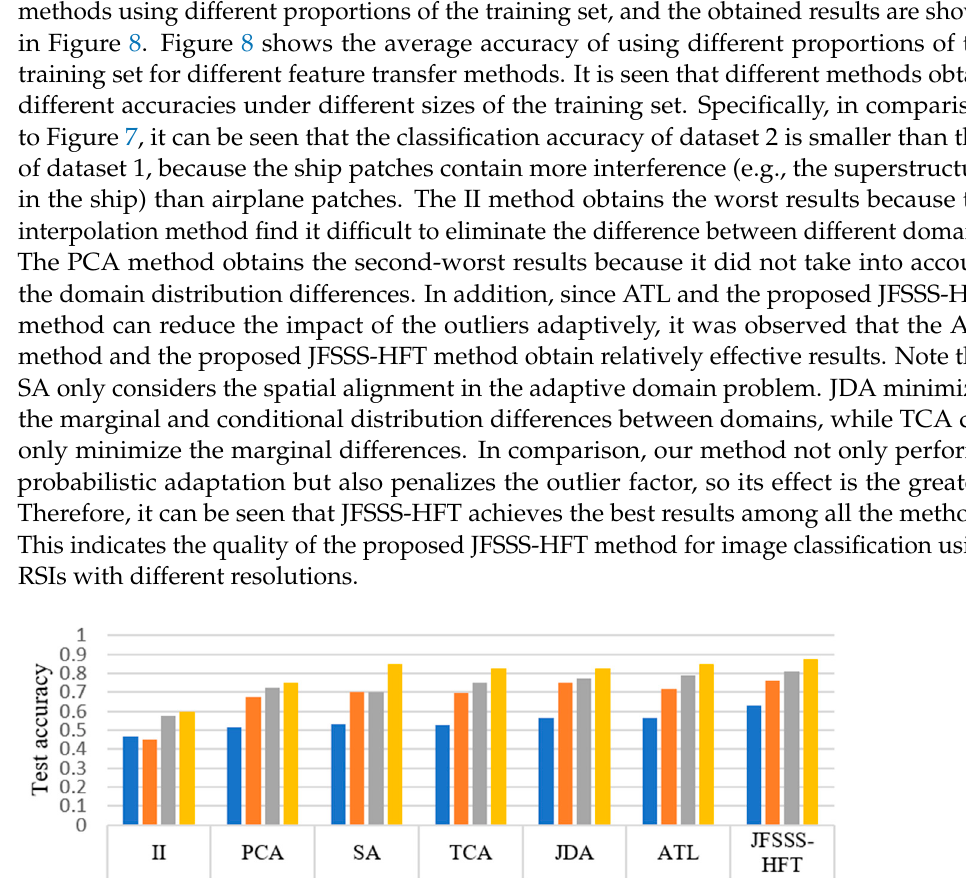
Table 1. Classification results of the proposed features transfer methods compared with deep learn- ing methods.